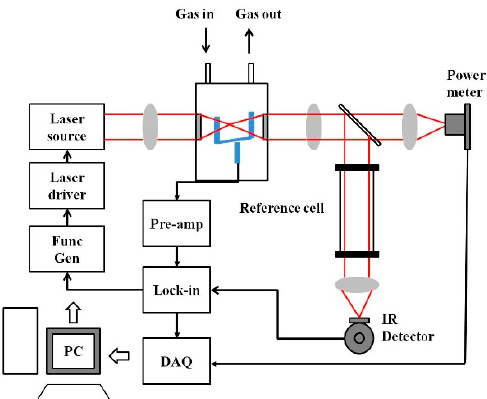
Figure 5. General quartz-enhanced photoacoustic spectroscopy (QEPAS) sensor architecture.